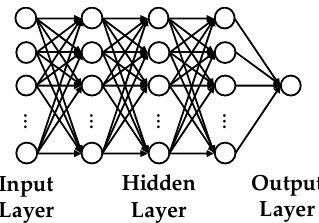
Figure 4. Illustration of a multilayer perceptron model.